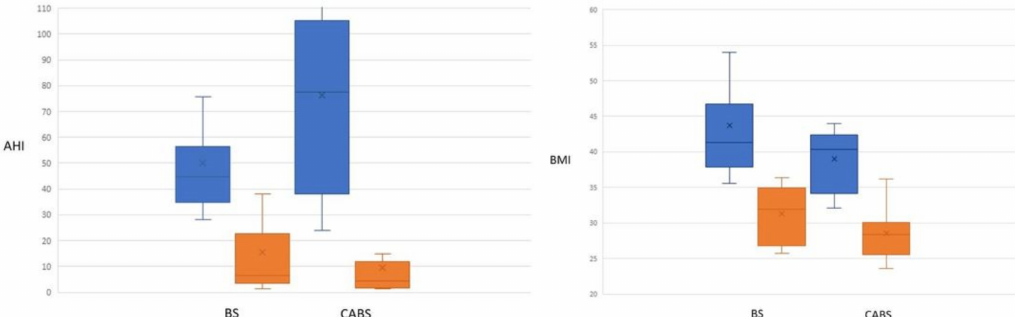
Figure 5. Perioperative changes in AHI and BMI in both BS group and CABS group. Preoperative (blue), postoperative (brown). CABS—combined airway and bariatric surgery, BS—bariatric surgery, BMI—body mass index, AHI—apnea–hypopnea index.